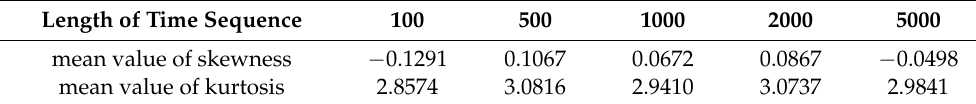
Table 1. The Joint Test of Skewness and Kurtosis of GC Difference Time Sequence.